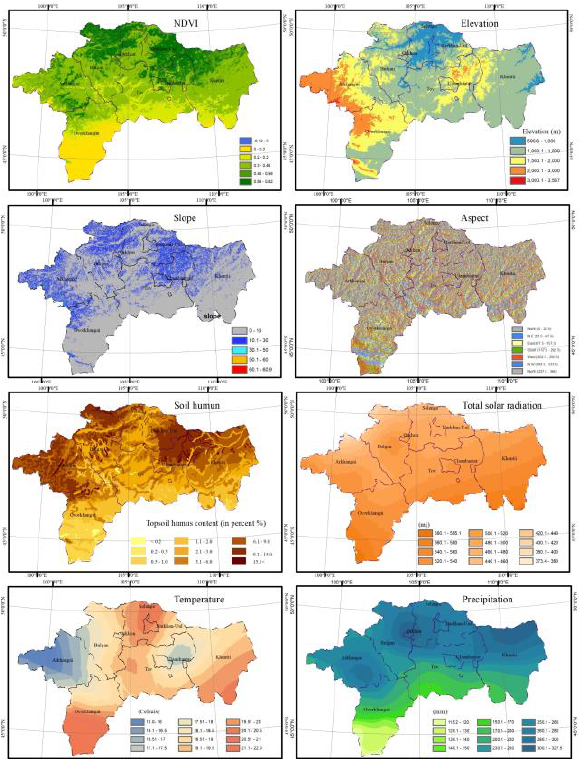
Figure 2. Agro-climate, soil and topographic factors, including precipitation, temperature, solar radiation, soil type, Soil humus, elevation, slope, aspect, and